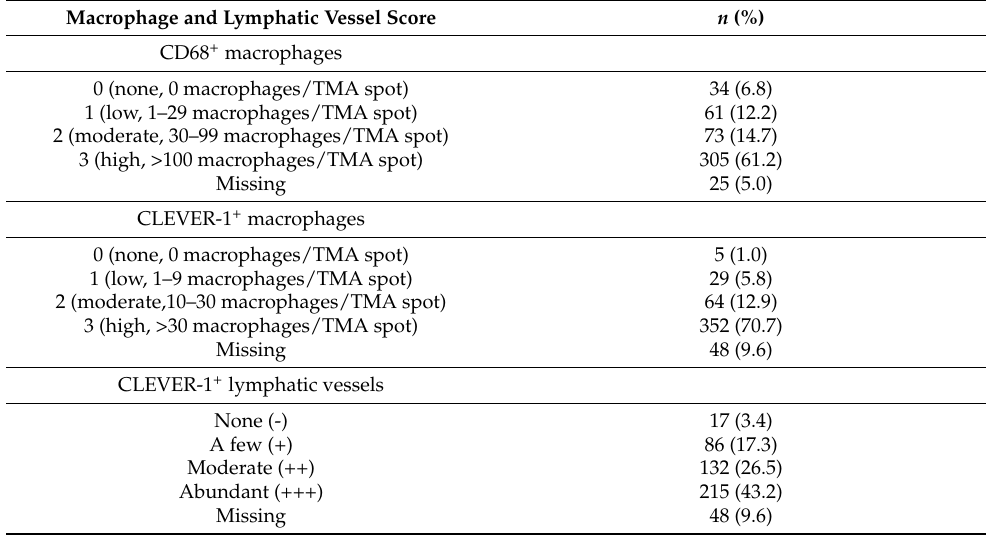
Table 3. Intratumoral CD68 + and CLEVER-1 + macrophage and CLEVER-1 + lymphatic vessel